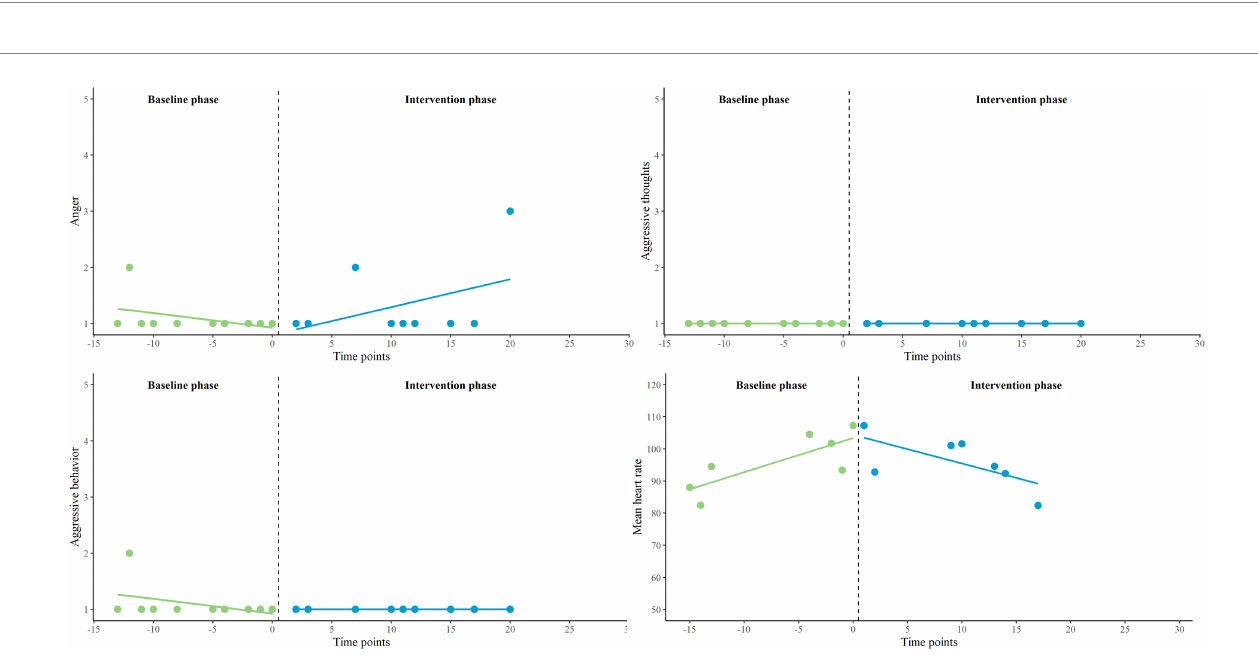
FIGURE 7 Representation of Joshua’s EMA measures (anger, aggressive thoughts and aggressive behavior) and HR (average), measured twice a day on a 5-point Likert scale, in baseline (A 1 ) and intervention phase (B).